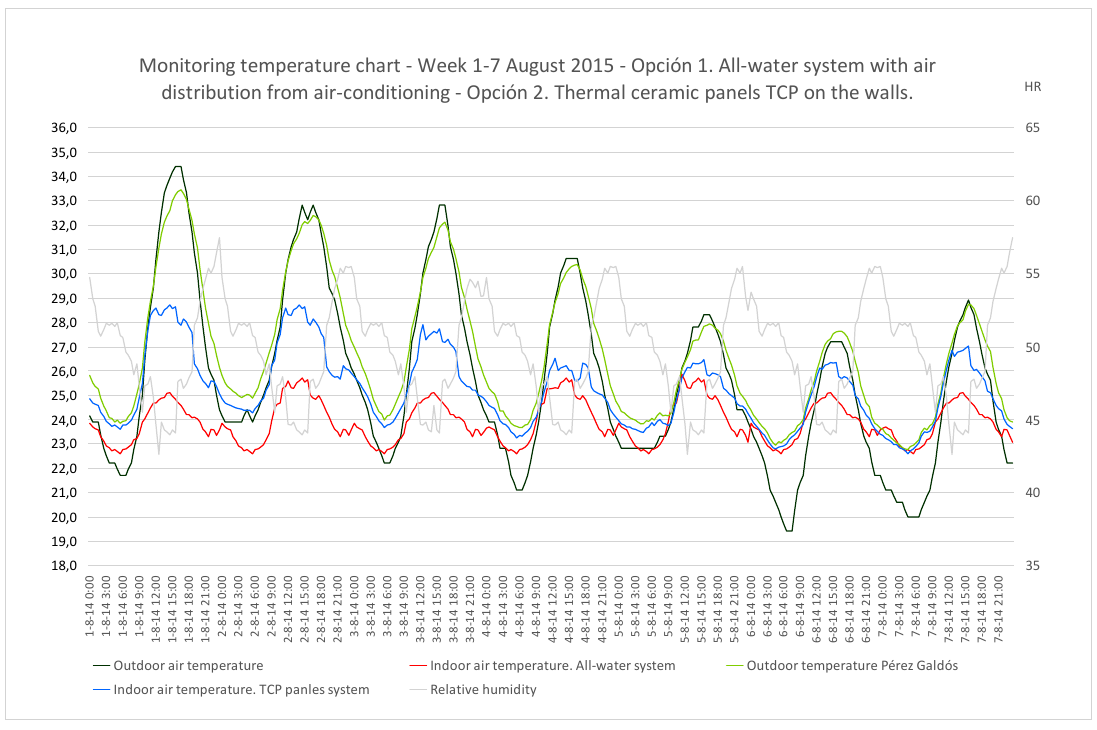
Figure 16. The parameters of outdoor and indoor air during a summer week.